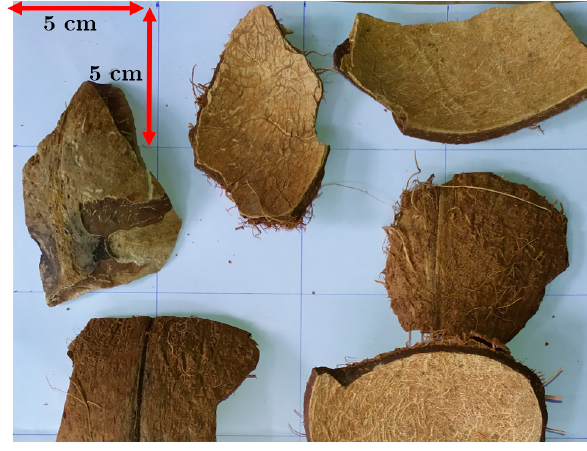
Figure 2. Raw coconut shell. Table 3. Ultimate and proximate analysis results (%adb)